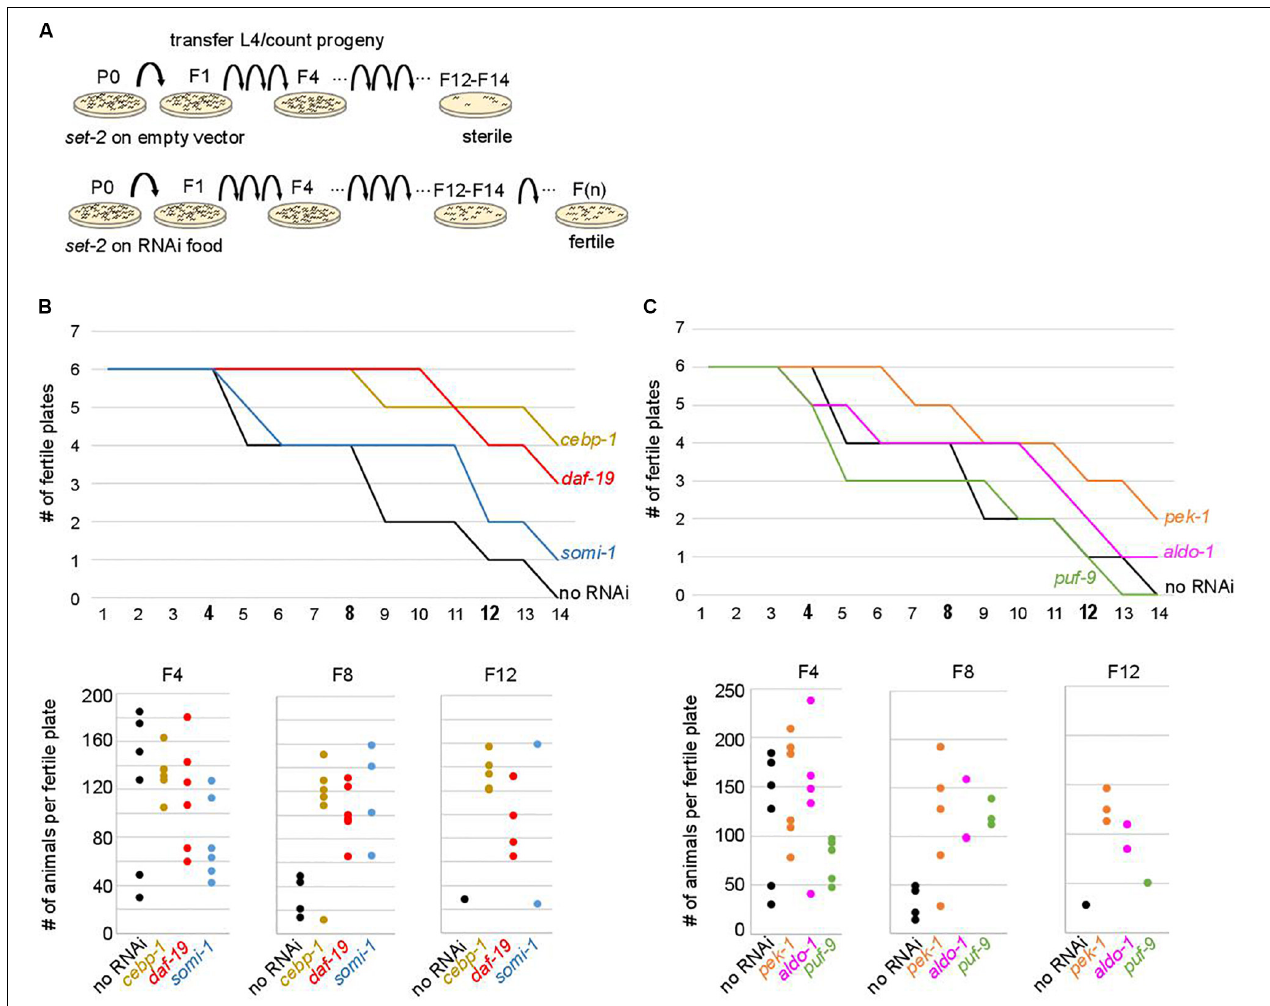
FIGURE 4 | Onset of sterility is delayed by RNAi knock-down of upregulated contributors. (A) Experimental design of the RNAi strategy used to test the effect of knock-down of upregulated contributors in set-2 dependent loss of germline identity. (B) cebp-1, daf-19, and somi-1 RNAi knock-down delays the onset of sterility compared to animals fed with an empty RNAi vector (no RNAi). Number of fertile plates (with less than 20 animals) per generation (upper panel) and number of animals per fertile plate in F4, F8, and F12 (lower panel) are shown. (C) pek-1 and aldo-1 but not puf-9 RNAi knock-down result in a delay in the onset of sterility compared to animals fed with an empty RNAi vector (no